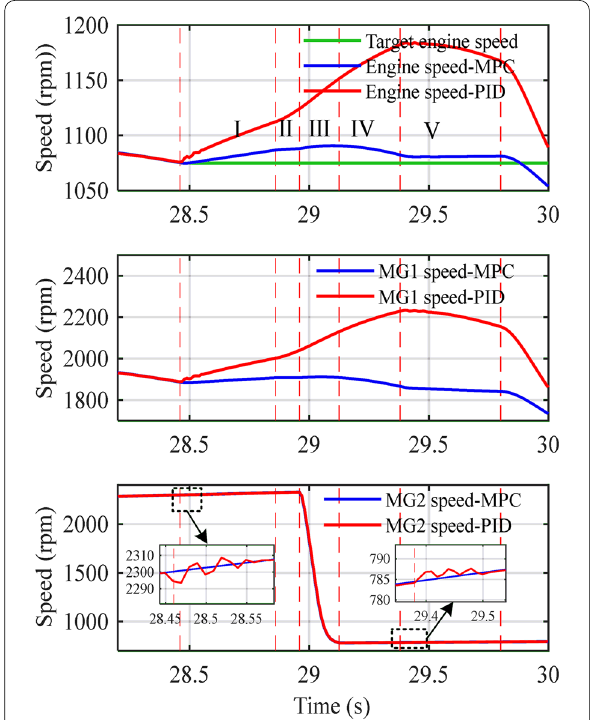
Figure 8 Speed of power sources when shifting